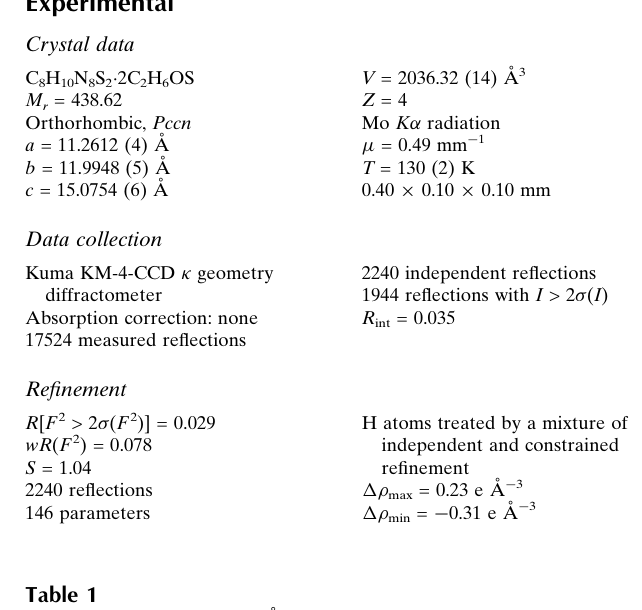
Hydrogen-bond geometry (A˚ , (cid:3) ). D —H (cid:1)(cid:1)(cid:1)